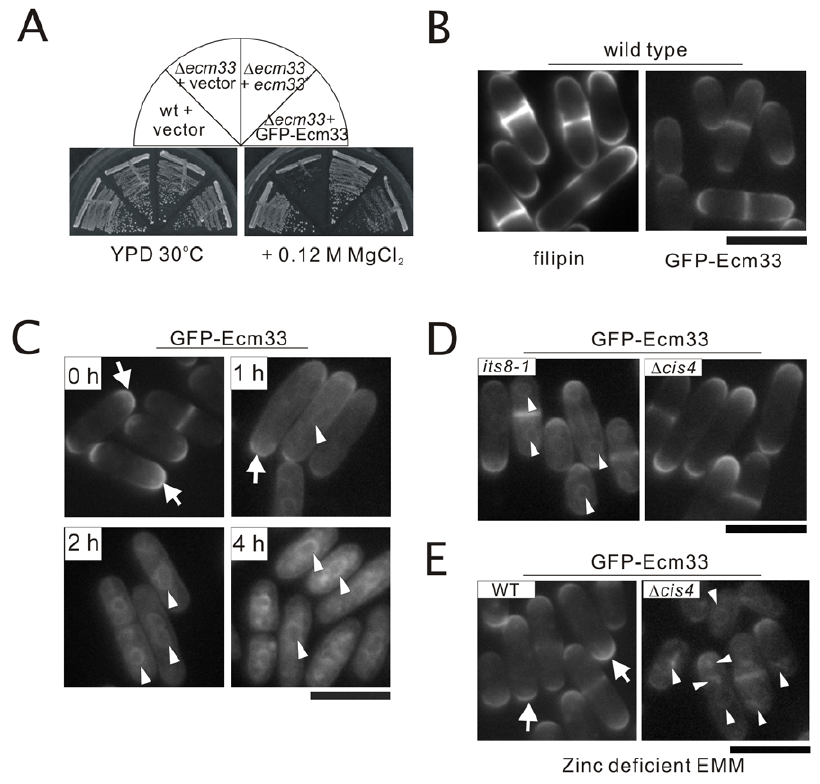
Figure 4. Subcellular localization of GFP-Ecm33. (A) GFP-tagged Ecm33 was functionally similar to the non-tagged protein. Cells transformed with the multicopy vector harboring gene encoding GFP-Ecm33 or the empty vector was streaked onto each plate containing YPD or YPD plus 0.12 M MgCl 2 , and then incubated for 4 days at 30 u C. (B) GFP-Ecm33 localized to the cell surface or medial regions in wild-type cells. Wild-type cells expressing chromosome-borne GFP-Ecm33 were cultured in EMM medium at 27 u C, and were examined by fluorescence microscopy; Sterol localization detected by filipin staining (see Materials and Methods) in wild-type cells. Bar: 10 m m. (C) GFP-Ecm33 localized to the structure surrounding the nucleus in wild-type cells when cells were treated with BE49385A. Wild-type cells expressing chromosome-borne GFP-Ecm33 were cultured in EMM medium and incubated at 27 u C, and were examined by fluorescence microscopy at 0 hour, 1 hour, 2 hour, and 4 hour after 1 m g/ml BE49385A was added to the medium. Bar: 10 m m. (D) GFP-Ecm33 primarily localized to the structure surrounding the nucleus and to the cell surface in its8-1 mutant, while the localization of GFP-Ecm33 was normal in D cis4 mutant. The its8-1 mutant and D cis4 mutant expressing chromosome-borne GFP-Ecm33 were cultured in EMM medium and incubated at 27 u C, and were examined by fluorescence microscopy. Bar: 10 m m. (E) In the zinc- deficient medium GFP-Ecm33 primarily localized to the intracellular dots and to the ER in D cis4 cells. The wild-type cells and D cis4 mutant expressing chromosome-borne GFP-Ecm33 were cultured in the zinc deficient EMM medium at 27 u C for 48 hours, and were examined by